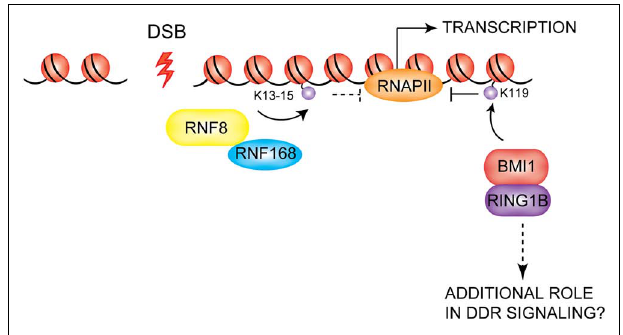
FIGURE 6 | Possible role of PcG proteins in the DDR. BMI1/RING1B are recruited to DSBs, where they are thought to mediate the transcriptional silencing observed at DSBs via deposition of the K119 mark on H2A-type histones. RNF8/RNF168 also may contribute to gene repression at DSBs. BMI1/RING1B may also play additional roles in DDR signaling which remain to be